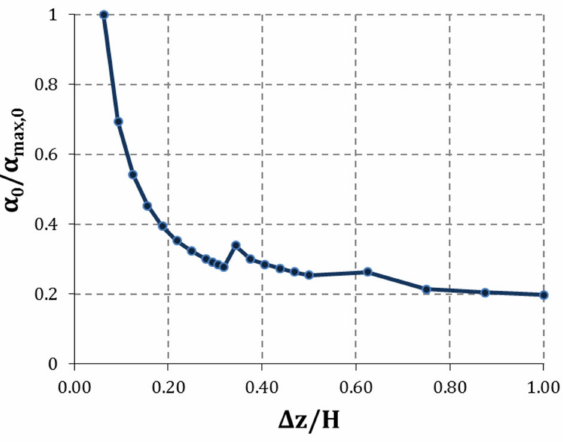
Figure 6. Two possible diagonal cracks (in black) along the height of the Vatopedi tower.